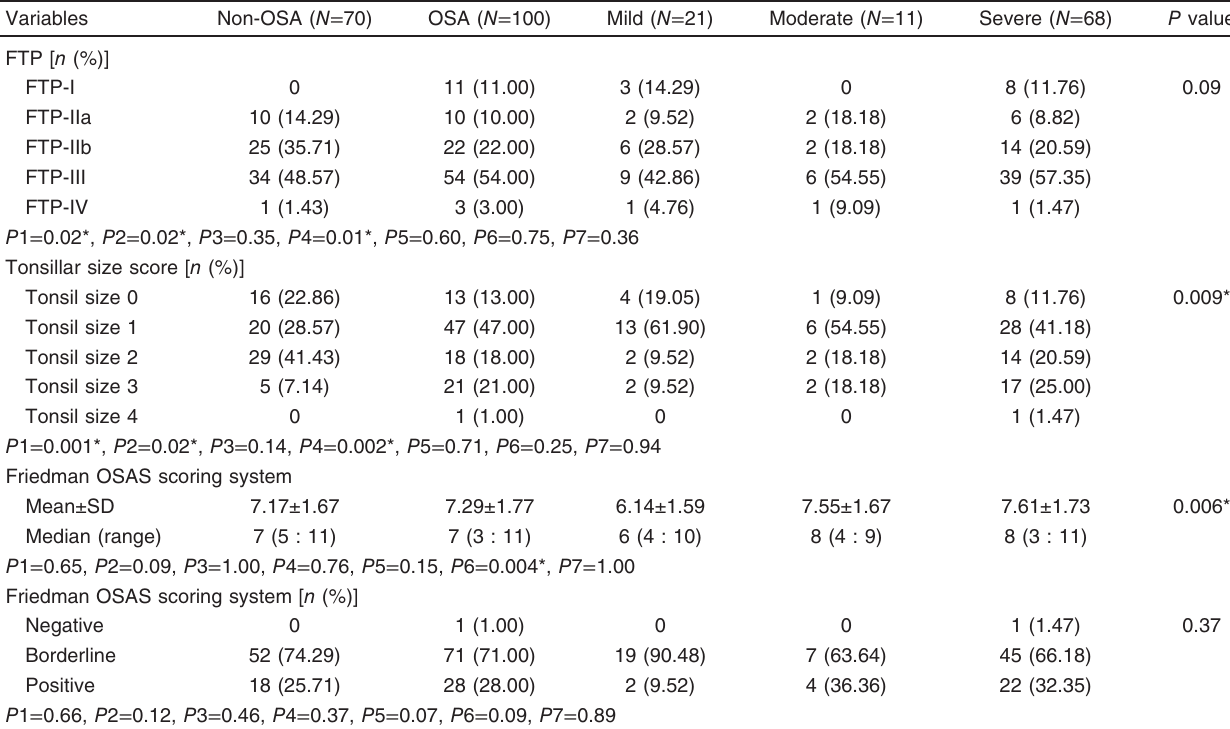
Table 3 Comparison between obstructive sleep apnea and Friedman tongue position, tonsillar size score, and Friedman obstructive sleep apnea syndrome scoring system of the studied populations Variables